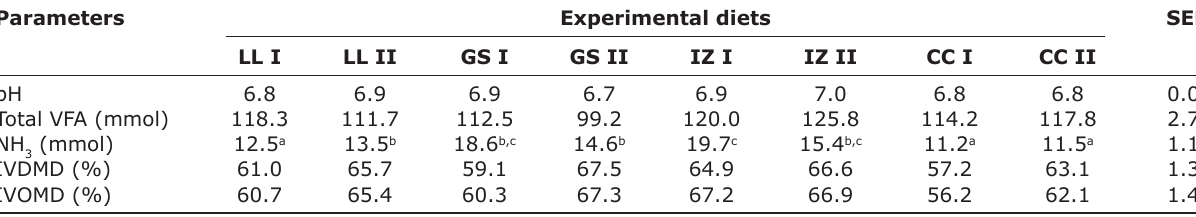
Table-3: Rumen fermentation profile of experimental diets after 48 h incubation. Parameters